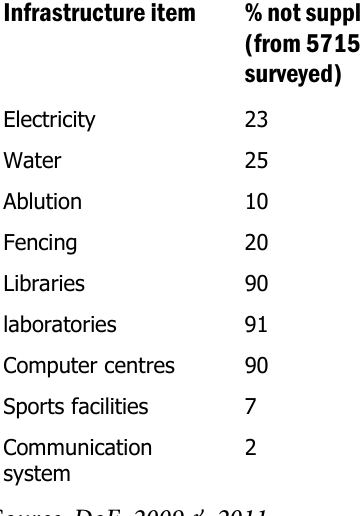
Table 5: Eastern Cape infrastructure in 2009 and